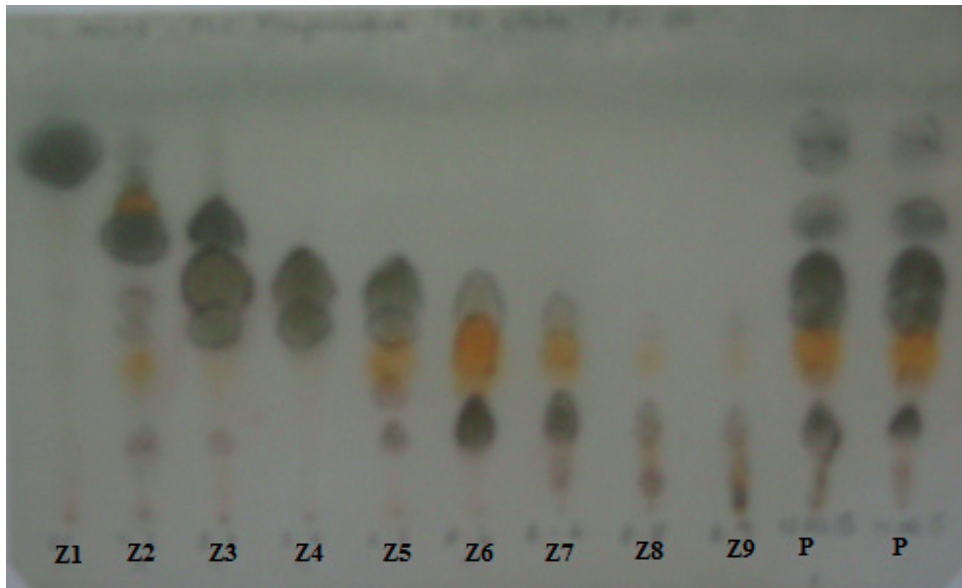
Figure 1. TLC analysis of the resin from A. chilensis tree naturally infected with P. austrocedri (P) (AR-15 sample) and the preparative TLC fractions Z1-Z9. Spots were revealed by spraying with p -anisaldehyde and heating. Silica gel, PE:EtOAc 8:2 ( v : v ).